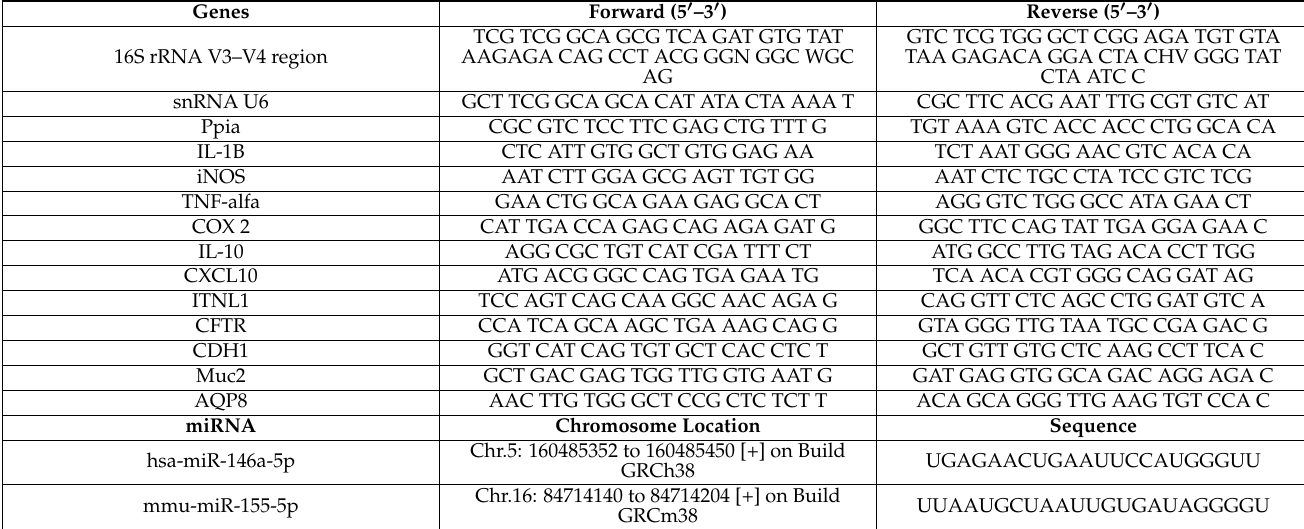
Table 2. Primer sequences for the targeted mouse genes and miRNAs (RT-PCR assay). Genes Forward (5 (cid:48) –3 (cid:48) ) Reverse (5 (cid:48) –3 (cid:48)